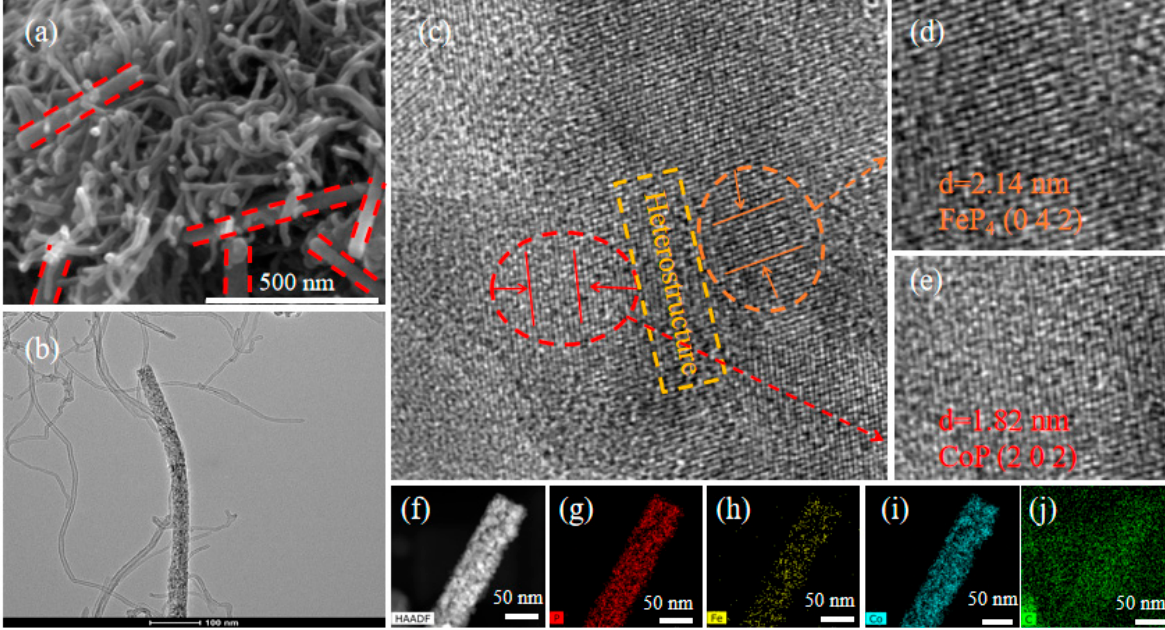
Figure 4. ( a , b ) SEM and TEM, ( c ) HRTEM, ( d , e ) are magnifications of the orange and red areas in ( c ), respectively, and the value of d in the diagram ( d , e ) represents the width of the 10 lattice stripes. ( f ) HAADF-STEM and ( g – j ) elemental mapping of CoP/FeP 4 @CNT.